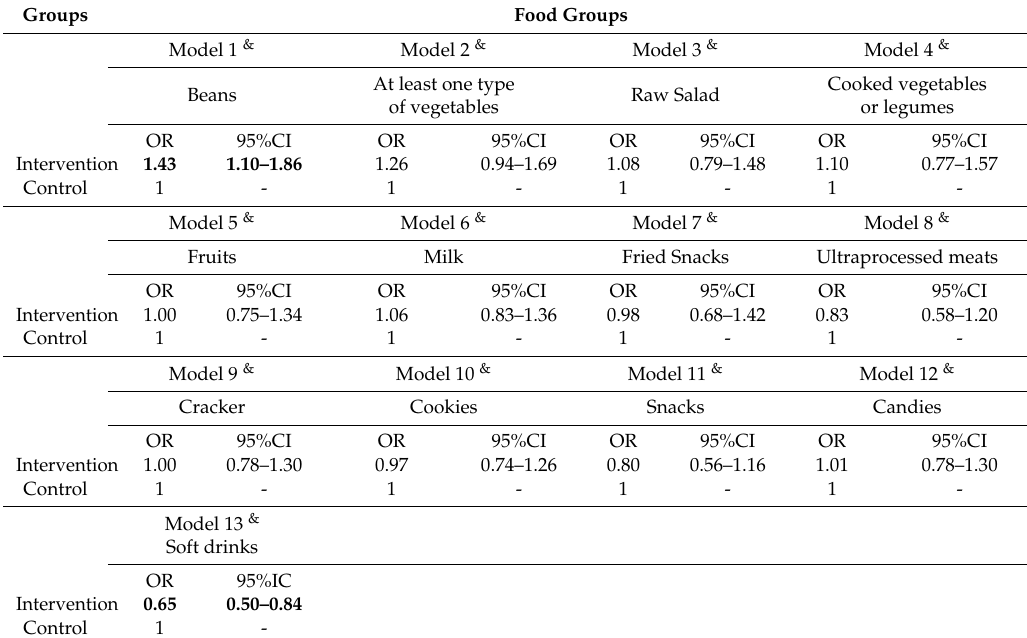
Table 6. Odds ratios (ORs) and corresponding confidence intervals (95% CIs) to assess the e ff ect of a program StayingFit on food consumption among study adolescents. Salvador-BA,